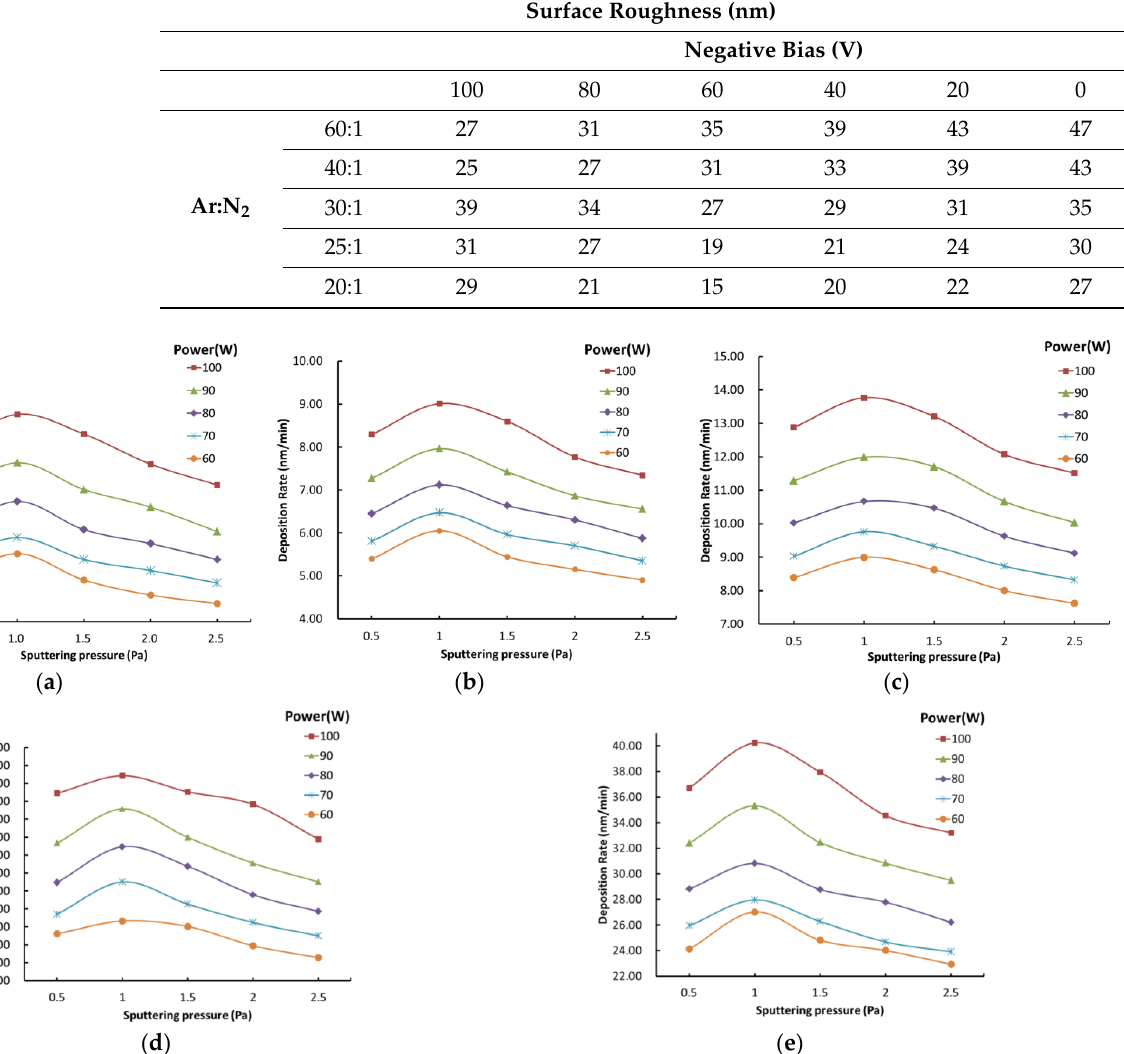
Figure 3. The influence of process parameters on the deposition rate of Al 2 O 3 film. ( a ) Ar:O 2 = 10:1; ( b ) Ar:O 2 = 20:1; ( c ) Ar:O 2 = 30:1; ( d ) Ar:O 2 = 40:1; ( e ) Ar:O 2 = 50:1.